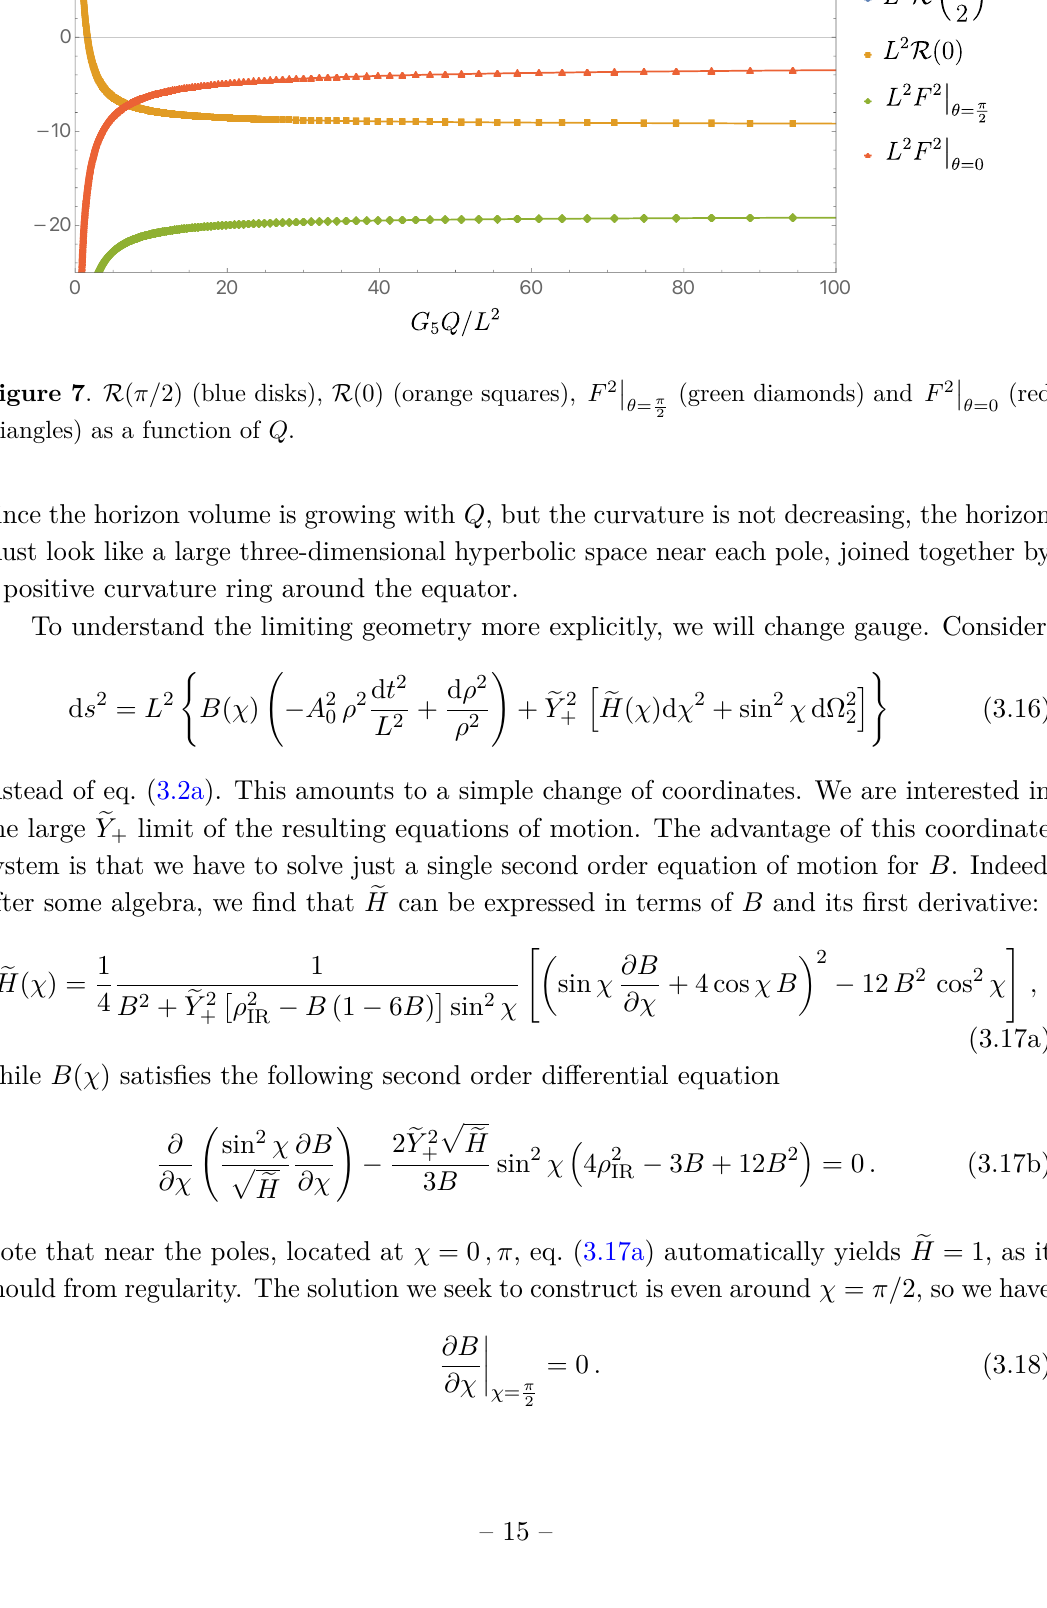
(cid:12) (red (cid:12) θ =0